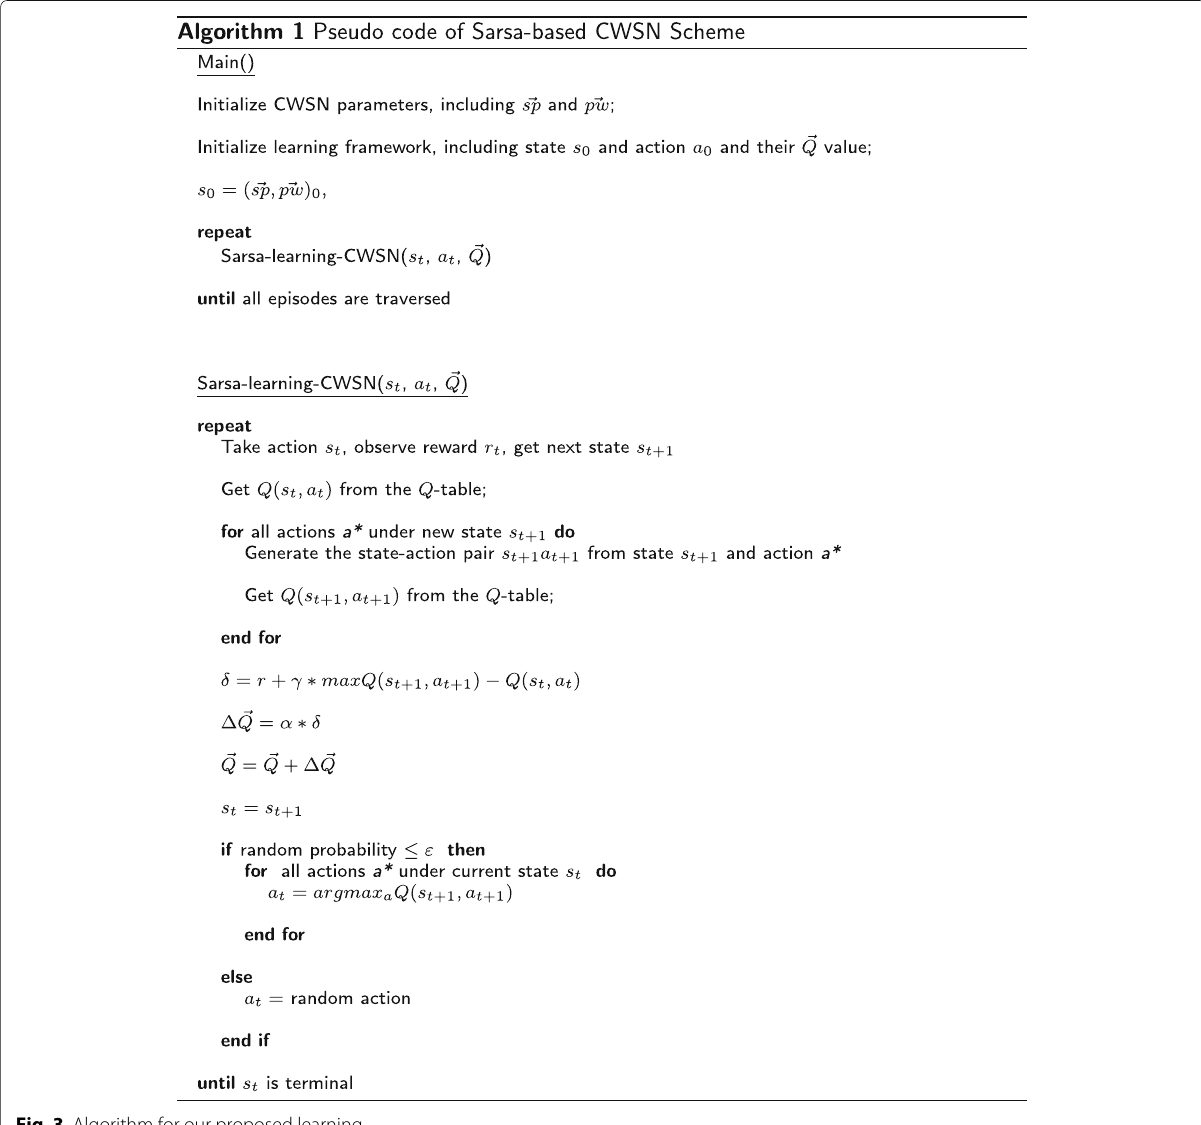
Fig. 3 Algorithm for our proposed